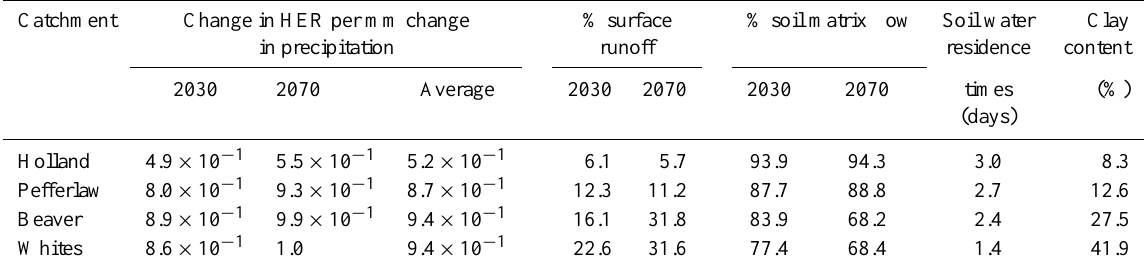
Table 7. Calculation of quantity of hydrologically effective rainfall (HER) (mm) generated per mm of precipitation (1d.p.), and comparison with catchment characteristics (hydrological and quaternary geology). Catchment Change in HER per mm change % surface % soil matrix flow Soil water Clay in precipitation runoff residence content 2030 Average